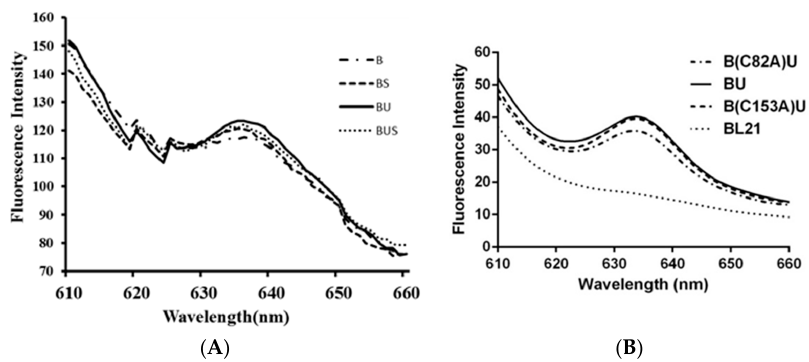
Figure 4. Fluorescence emission spectra of the recombinant strains ( A ) and mutant strains ( B ). All samples have been measured for three times.